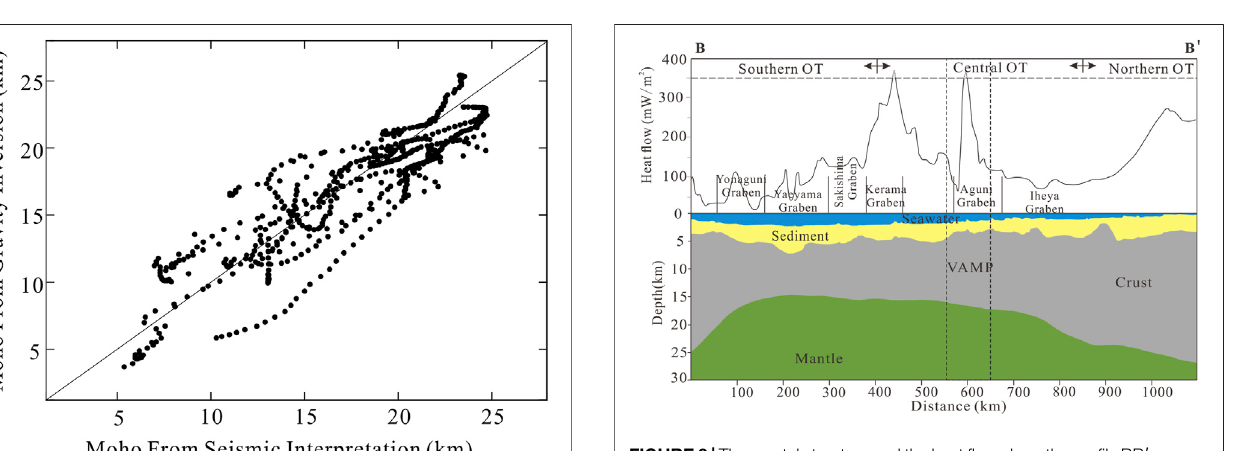
FIGURE8| Thecrustal structure and theheat fl owalongthe pro fi leBB ′ ; pro fi lelocationisshownin Figure5A .Thedatasourcesarethesameasthose in Figure 7